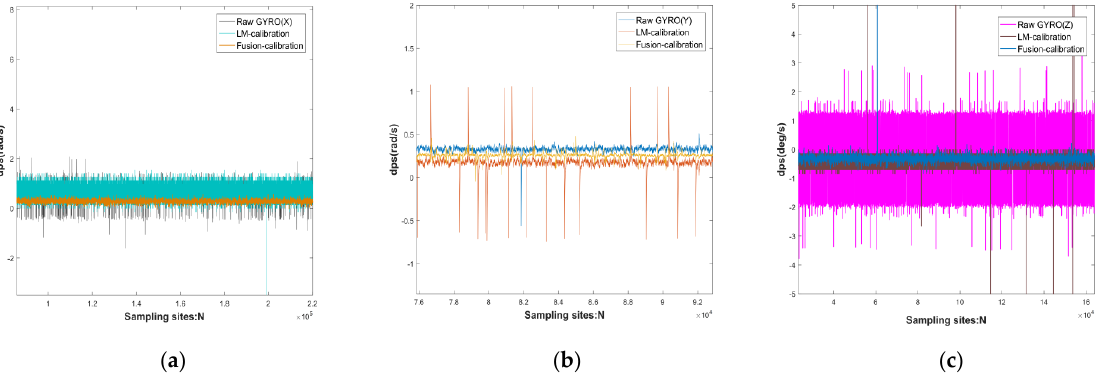
16 of 23 Table 7. MEMS0 accelerometer performance parameter ratio graph. Axial